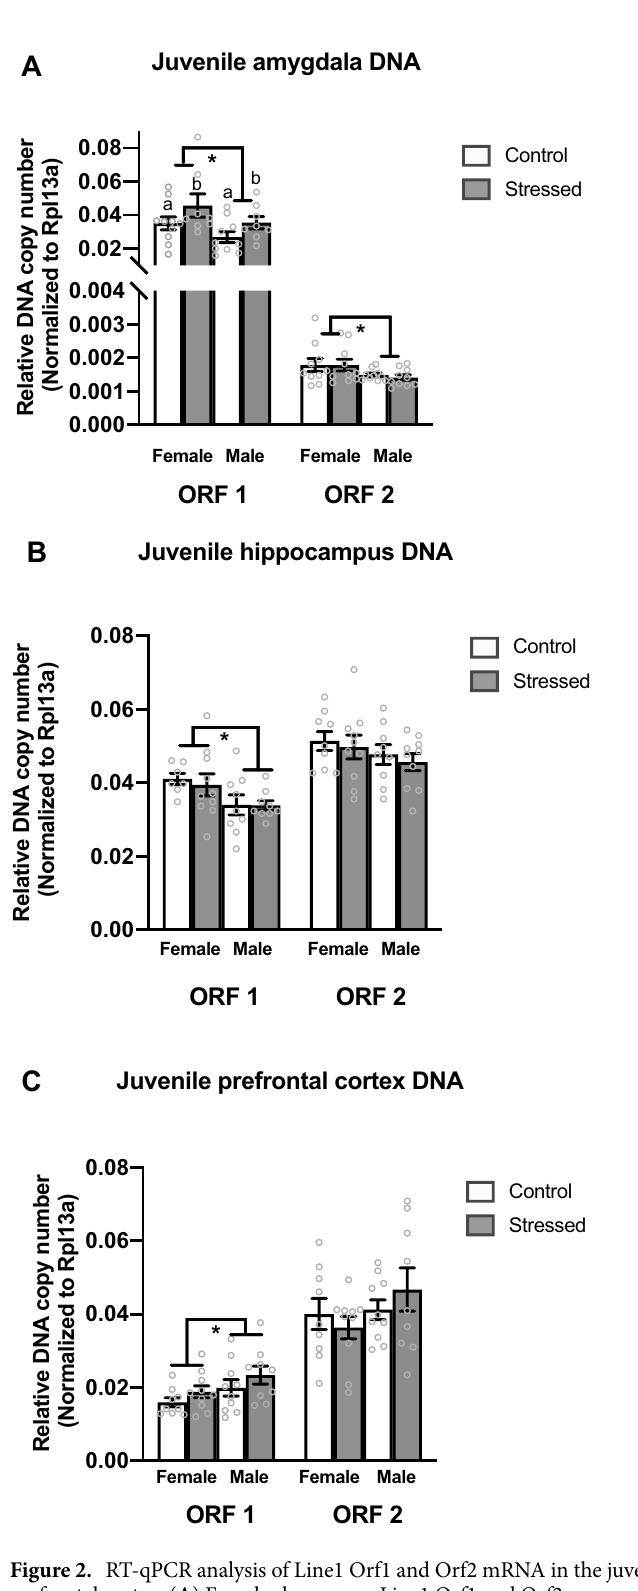
Figure 2. RT-qPCR analysis of Line1 Orf1 and Orf2 mRNA in the juvenile amygdala, hippocampus, and prefrontal cortex. ( A ) Females have more Line1 Orf1 and Orf2 copy number in the amygdala than males. ( B ) Females have more Line1 Orf1 copy number in the hippocampus than males. ( C ) Males have more Line1 Orf1 copy number in the prefrontal cortex than females. Values shown as mean ± SEM. *Indicates p <